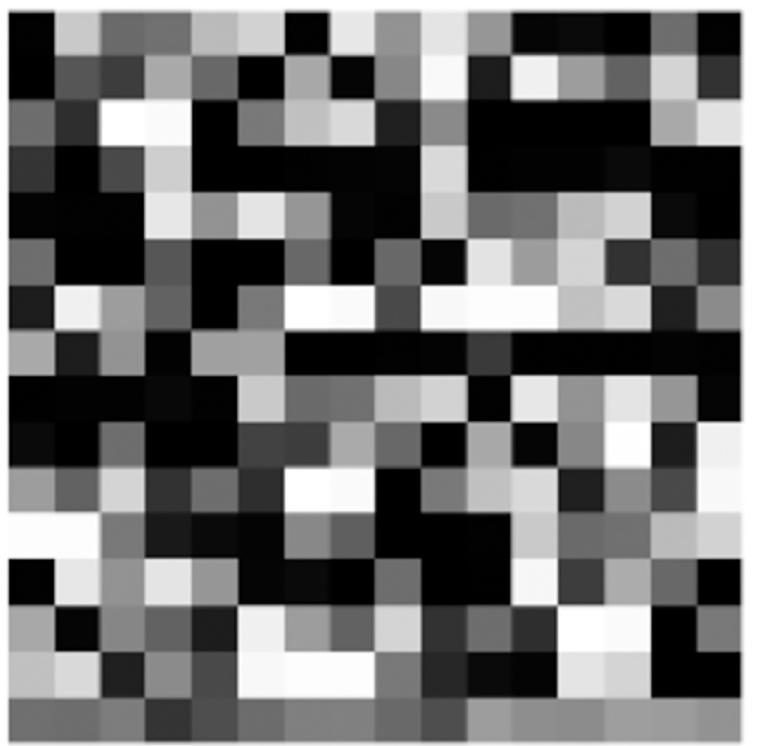
Fig 3. Visualization of a session sample.